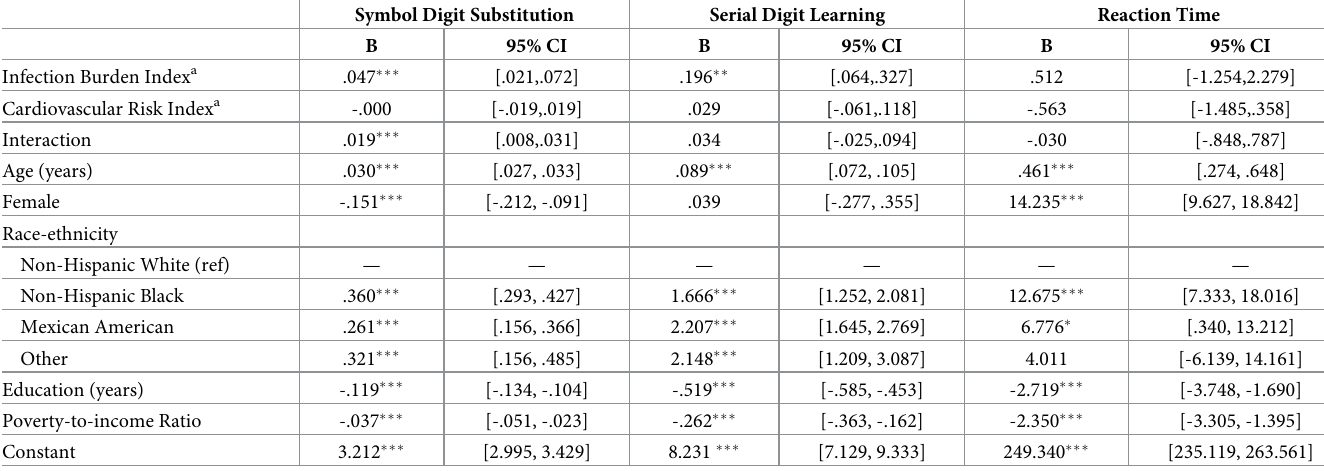
Table 2. Interaction effects of an infection-burden index and cardiovascular-risk index and association with cognitive function in U.S. adults aged 20 to 59 years.